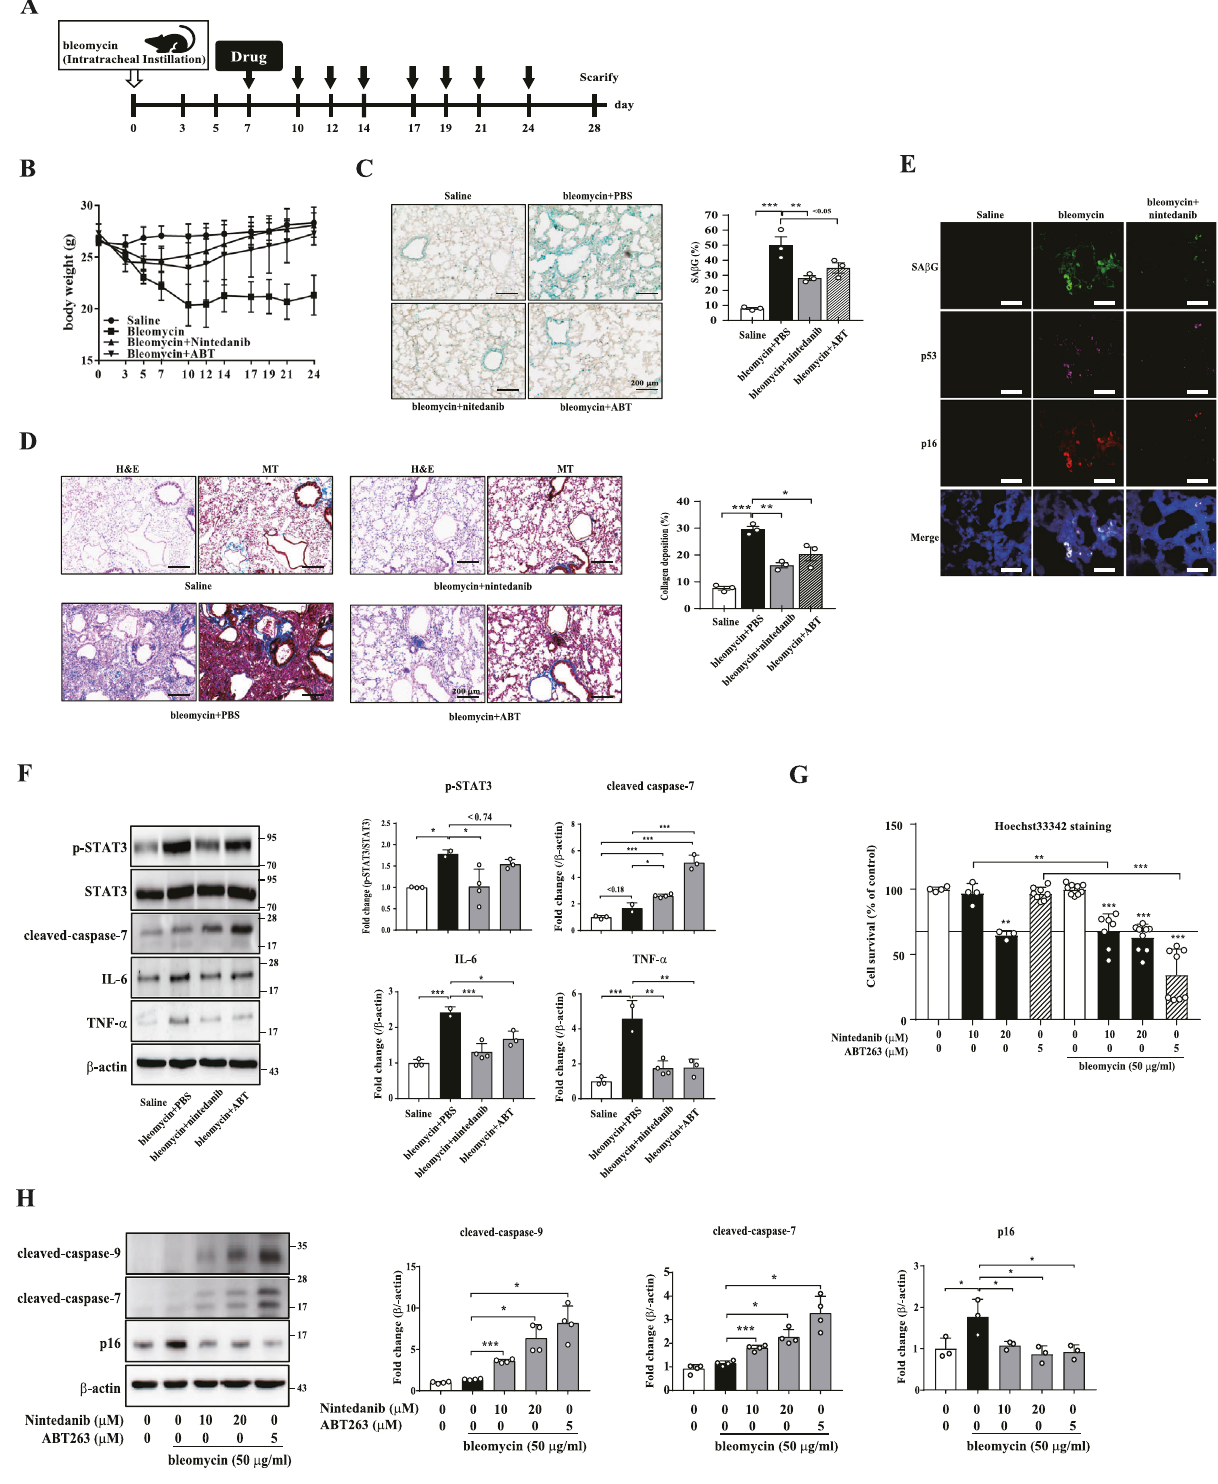
nintedanib treatment downregulated the protein expression of CDK inhibitors, including p53 and p16 (Fig. 5E) and inhibited the phosphorylation of STAT3 (Fig. 5F) in bleomycin-treated lung tissue. Nintedanib treated tissues also showed reduced expression of IL-6 and TNF- α , known as SASPs, and increased level of cleaved caspase-7 (Fig. 5F), which would be expected as a consequence of nintedanib-induced senolysis. To test the senolytic effect